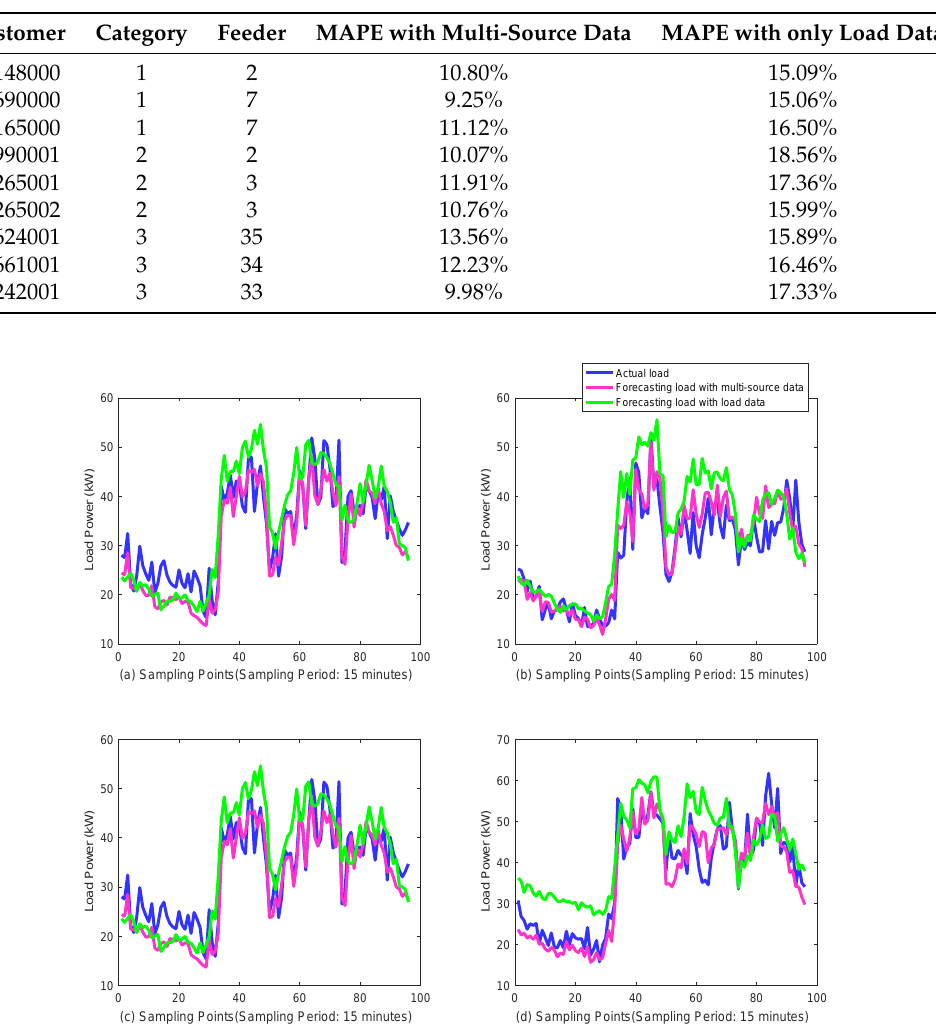
Figure 13. Comparison curve of actual load and forecasting load of Customer 53990001 with or without multi-source data: ( a – d ) the results for the same four days in November 2013 as the experiment in Figure 12.